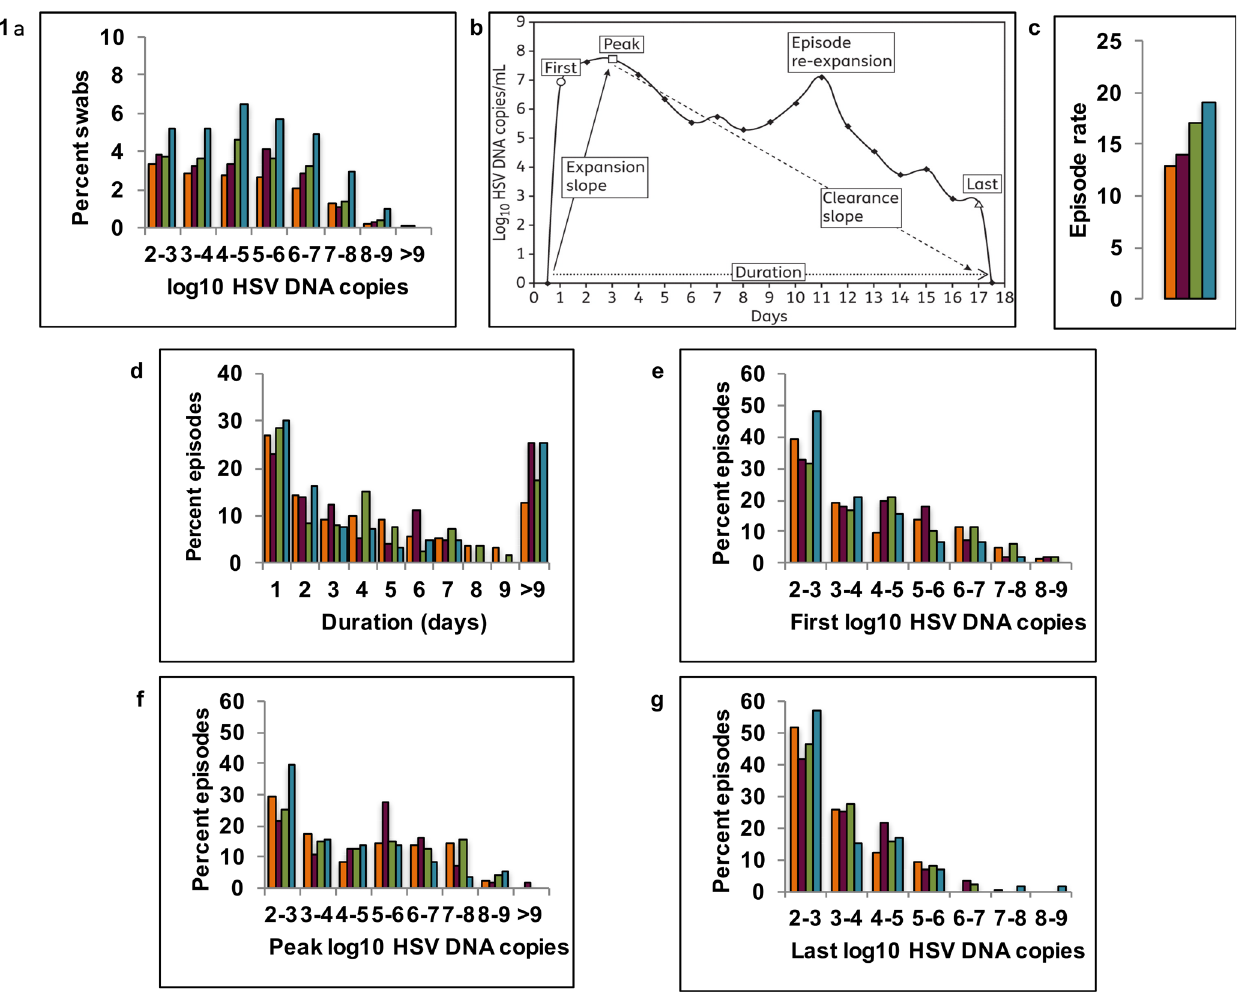
Fig 1. Increased HSV-2 shedding rate, episode rate and episode duration in HIV infected men. Frequency histograms of HSV-2 shedding in cohorts of HIV negative (orange), and HIV positive men with CD4+ T-cells > 500/ μ L (magenta), 200-499/ μ L (green) and < 200/ μ L (teal). ( A) Quantitative shedding per swab; (B) Shedding episode classification scheme (adapted from reference 4; ( C) Annualized episode rate; ( D) Duration, ( E) First positive viral load, (F ) Peak positive viral load & ( G) Last positive viral load per